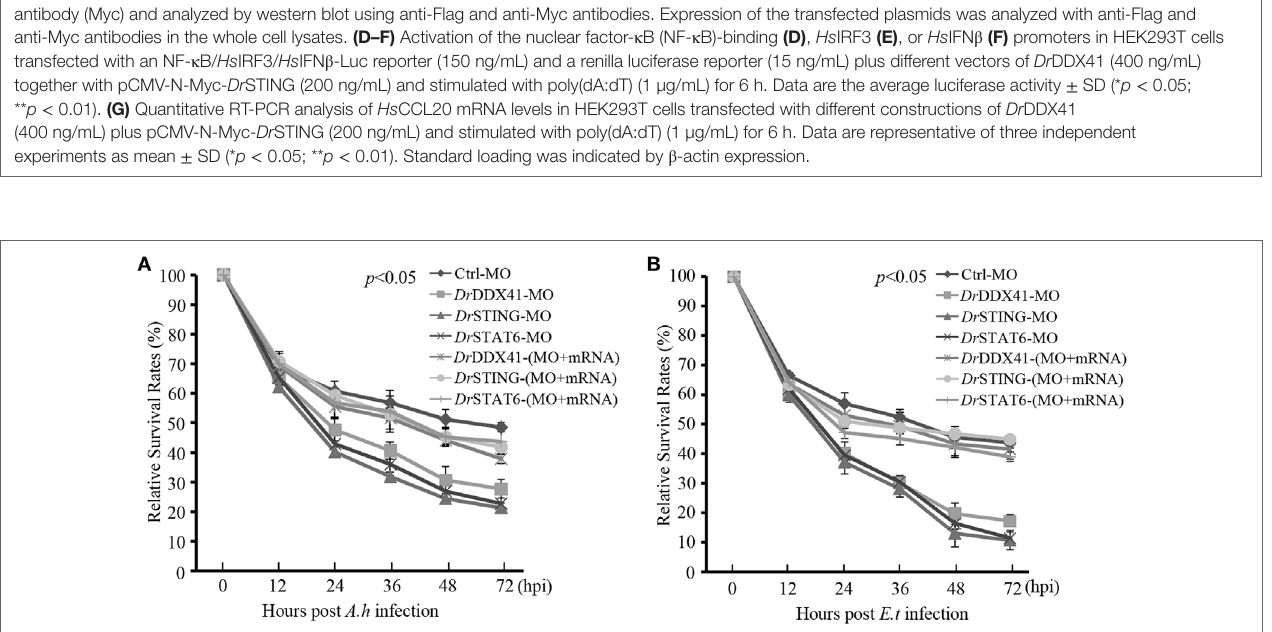
FigUre 10 | Antibacterial function of Danio rerio DDX41 ( Dr DDX41) in zebrafish embryo model. Relative survival rates of Aeromonas hydrophilia (a) and Edwardsiella tarda -infected (B) zebrafish embryos in knockdown and rescue experiments. Zebrafish embryos were microinjected with standard-MO (Ctrl-MO), Dr DDX41/ Dr STING/ Dr STAT6-MO or together with their corresponding mRNAs, and raised to 24 hours post fertilization. Then, the embryos were exposed to PBS, A. hydrophilia , or E. tarda at 10 6 cfu/mL for 5 h by immersion and monitored for 72 h. The survived embryos were calculated at 12, 24, 36, 48, and 72 hours post infection. Data are representative of three independent experiments as mean ± SD (* p < 0.05; ** p < 0.01).